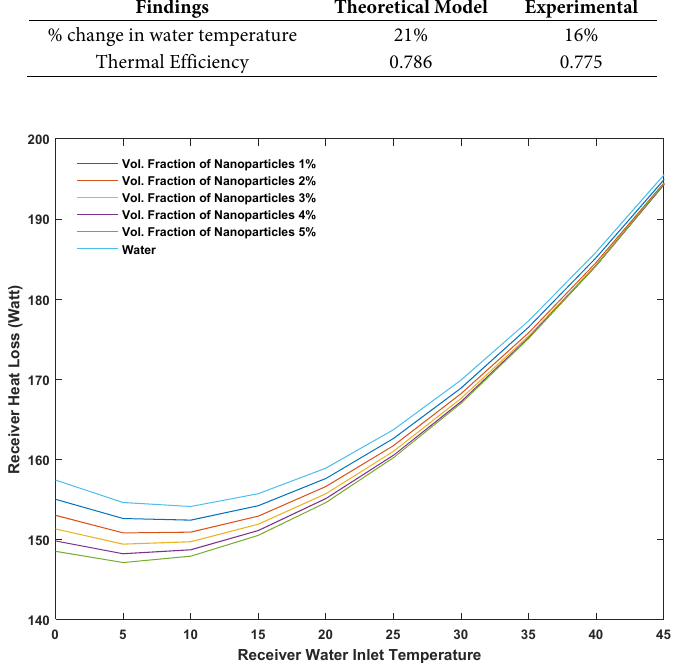
Fig. 6. Effect of volume fraction of the nanoparticle on the receiver heat loss